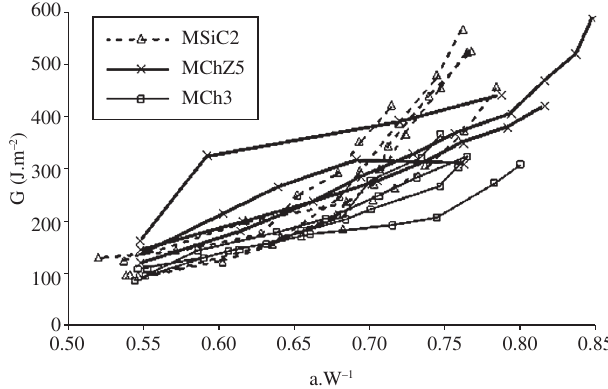
Figure 3. Maximum stress intensity factor, K specimens; and b) large test specimens.